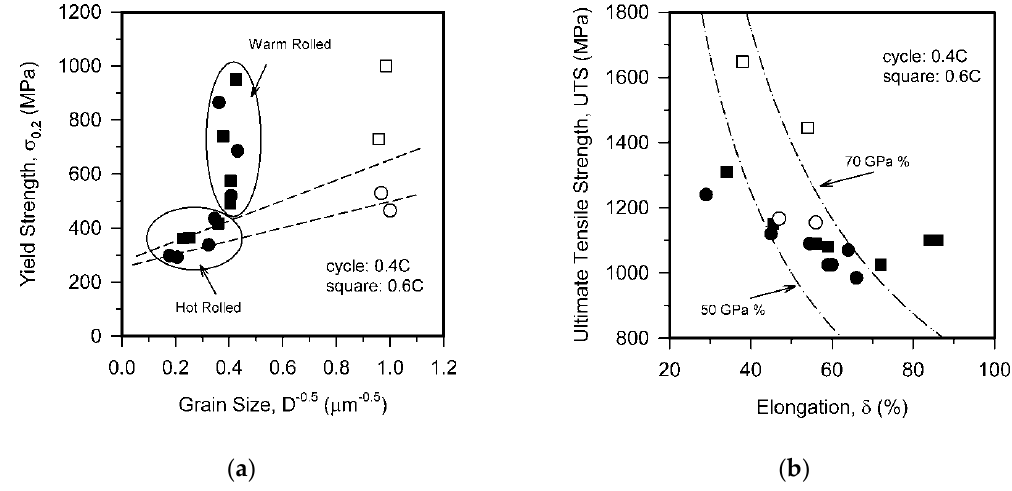
Figure 7. Relationship between the grain size and the yield strength ( a ) and the ultimate tensile strength and elongation ( b ) for Fe-0.4C-18Mn and Fe-0.6C-18Mn steels (0.4C and 0.6C, respectively) processed by warm to hot rolling (filled symbols [10]) and cold rolling followed by annealing (open symbols, present study).